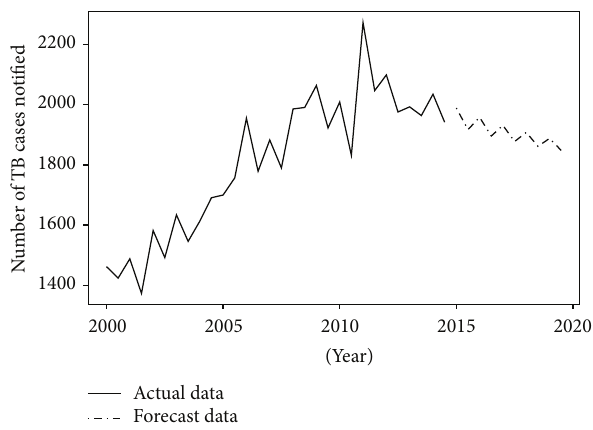
Figure 5: Trend of TB cases in Benin between 2000 and 2014 and forecasted number of TB cases from 2015 to